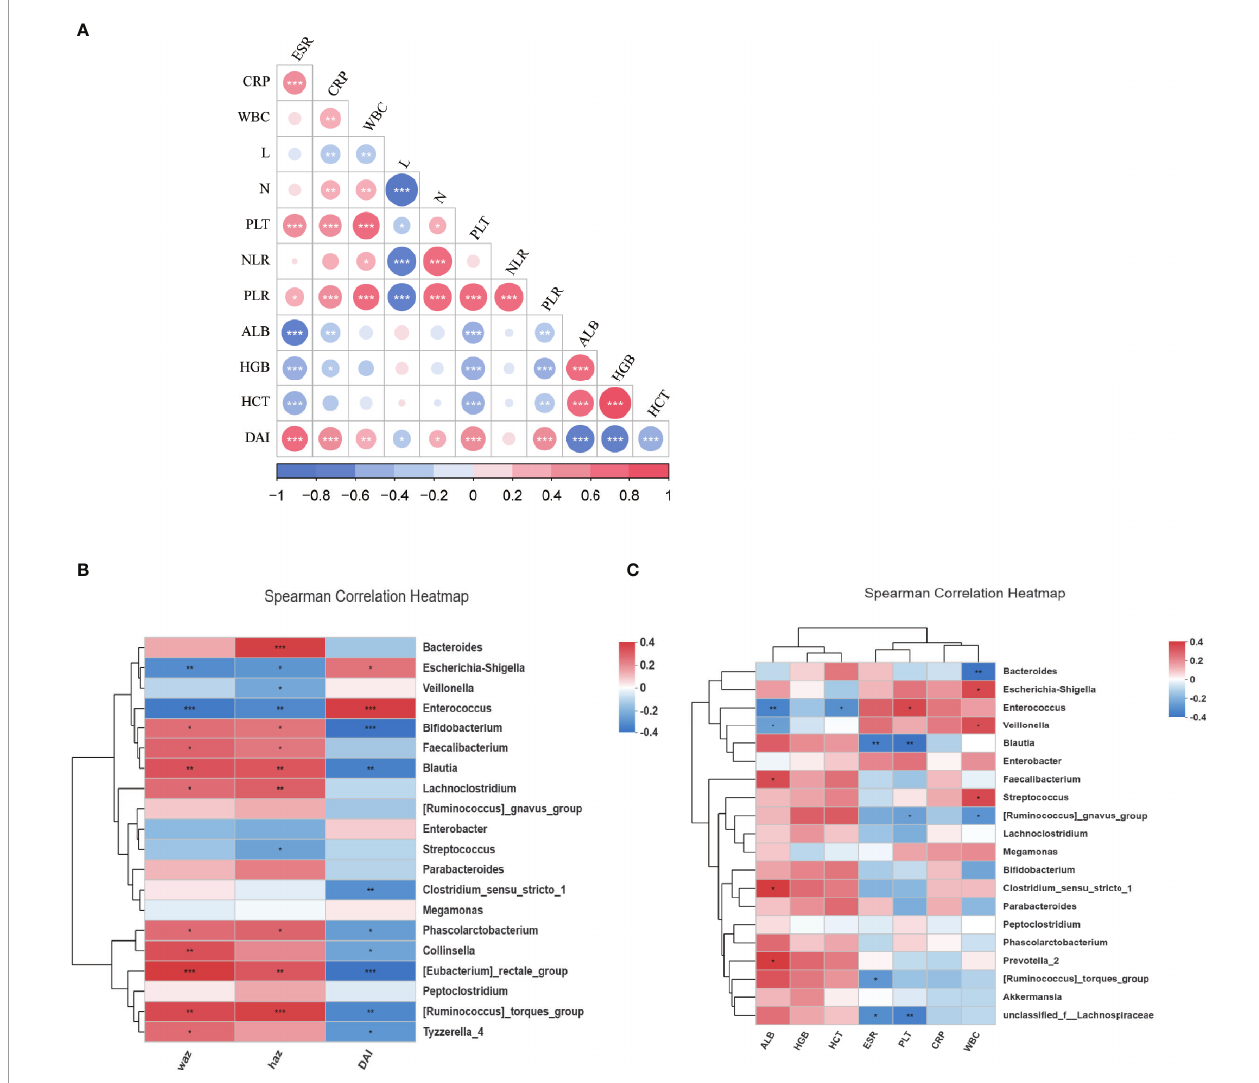
FIGURE 3 | The relationship of microbiota and clinical characteristics in IBDs. (A) showed the Spearman analysis of in fl ammatory markers, nutrition markers, and the DAI score. A positive correlation is shown in red and a negative correlation is shown in blue. (B) A heatmap of Spearman correlation between microbiota at genus level and DAI, WAZ, and HAZ. (C) A heatmap of Spearman correlation between microbiota at genus level and in fl ammatory markers (WBC, CRP, PLT, ESR, NLR, PLR) and nutrition markers (ALB, HGB, HCT). IBD, in fl ammation bowel disease; DAI, disease activity index; HAZ, z score for height of age; WAZ, z score for weight of age; WBC, white blood cells; PLT, platelets; CRP, C-reactive protein; ESR, erythrocyte sedimentation rate; N, neutrophil; L, lymphocyte; NLR, neutrophil- to-lymphocyte ratio; PLR, platelet-to-lymphocyte ratio; ALB, albumin; HGB, hemoglobin; HCT, hematocrit. *P < 0.05, **P < 0.01, ***P <